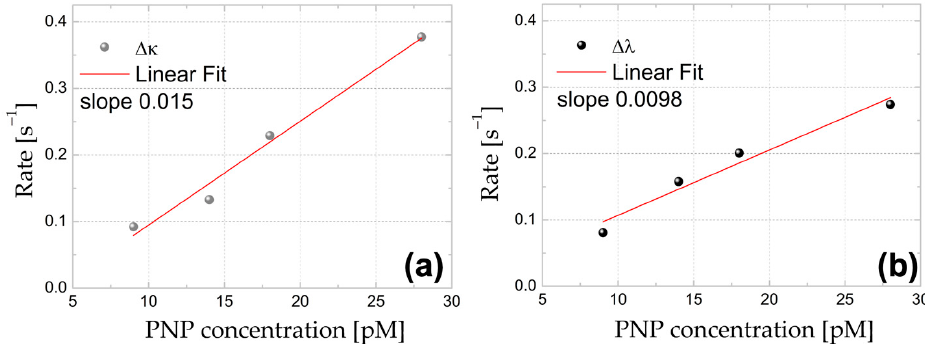
Figure 3. Event rates for ( a ) Δκ and ( b ) Δλ obtained from time series for increasingly higher Au-